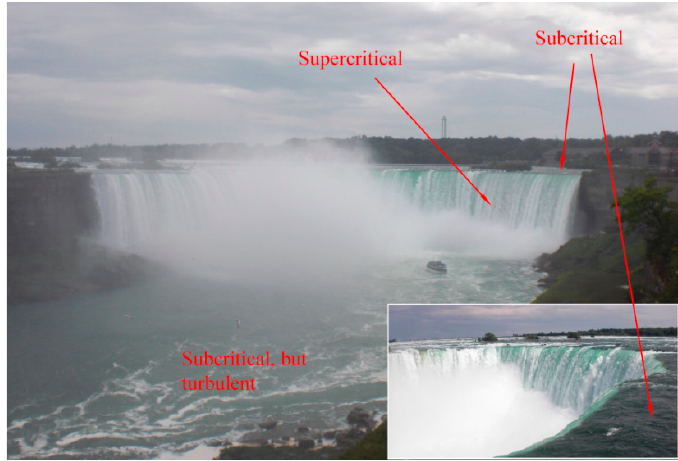
Figure 2. Subcritical and supercritical regimes in the Niagara Falls.